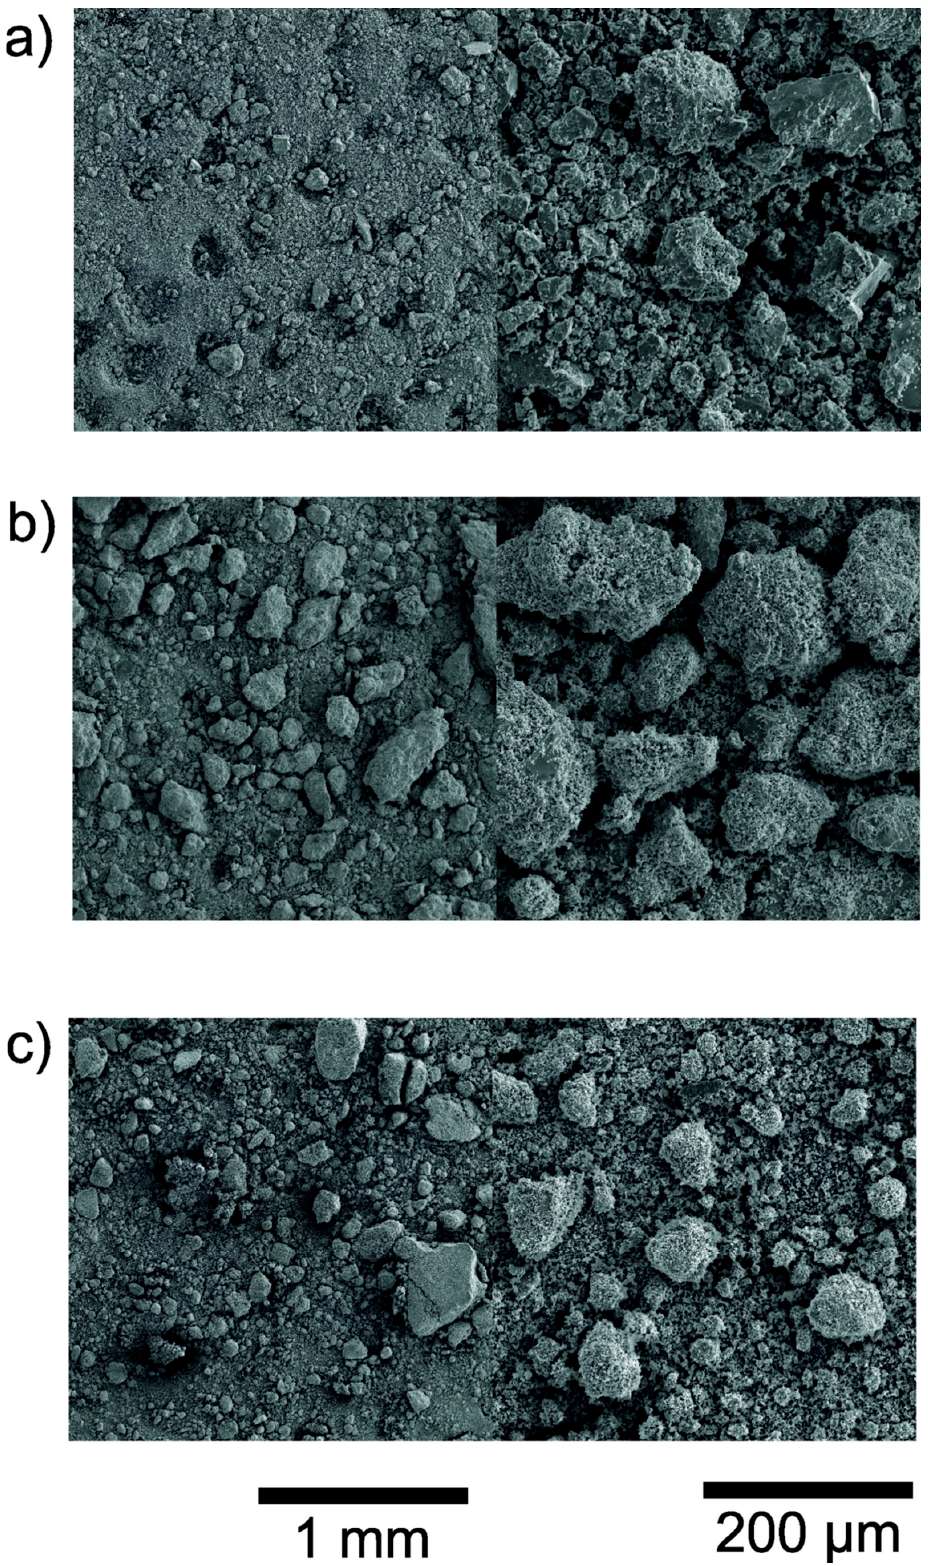
Figure 4. SEM microphotographs of Ti23Zr25Nb-based composites powder agglomerates with the ( a ) 3 wt.%, ( b ) 6 wt.%, and ( c ) 9 wt.% 45S5 Bioglass content mechanically alloyed for 16 h.